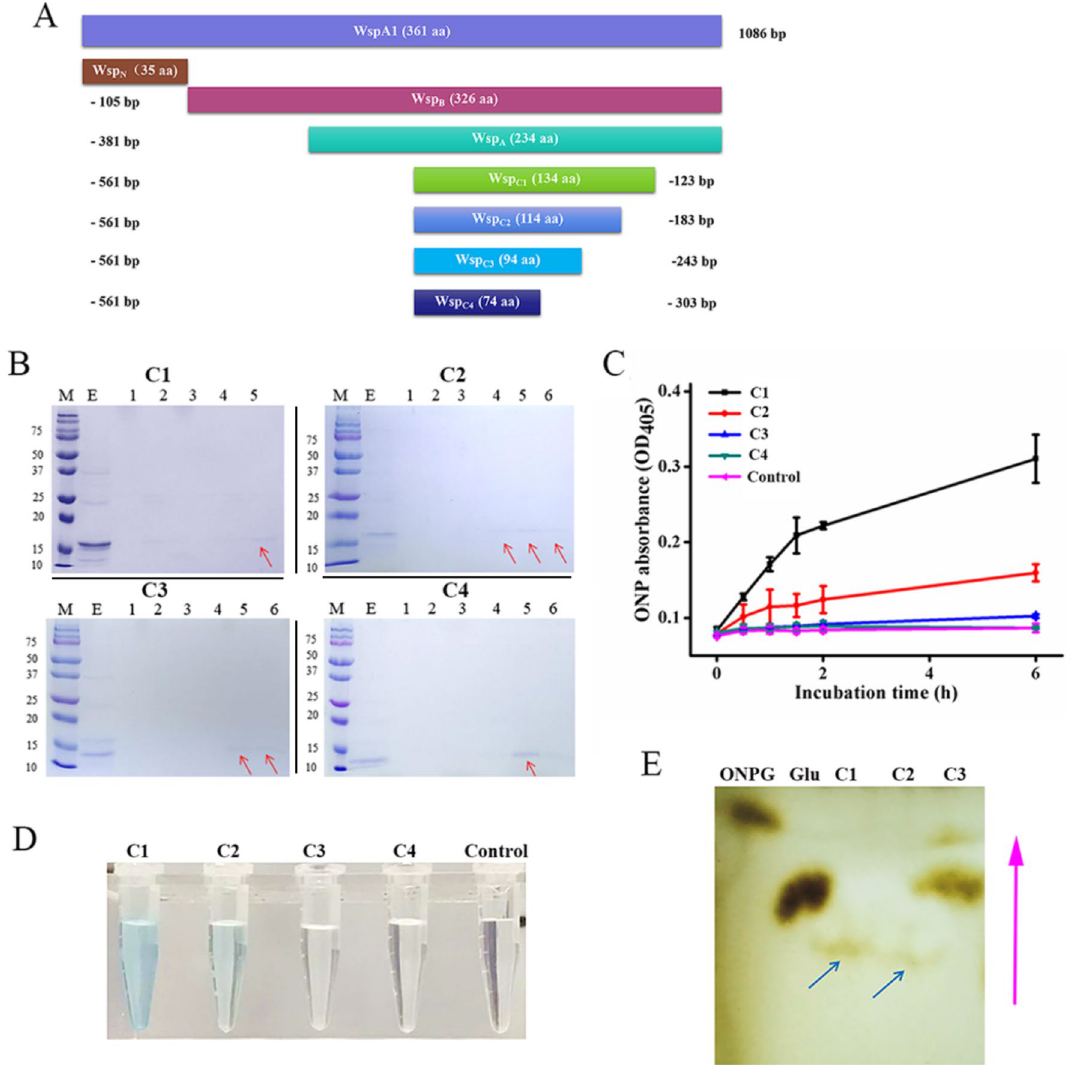
Figure 5. Biochemical analysis of the truncated proteins of WspA1. ( A ) An illustration of the truncated protein variants. ( B ) Protein profiles of the in vitro expressed and purified target proteins in SDS-PAGE gels. M marker protein, E eluted fraction. No. 1–6, the purified fractions by FPLC. The red arrows indicate the target proteins. C1, C2, C3 and C4 represent Wsp C1 , Wsp C2 , Wsp C3 , and Wsp C4 , respectively. ( C ) Comparative analysis of hydrolytic activities in 0.1 M PBS buffer (pH 7.5) with ONPG as the substrate. Data shown are means ± SD ( n = 3). Protein concentrations, 10 μg/ml. ONPG, 3 mM. Control, no addition of any protein in the reaction buffer. ( D ) In vitro activity analysis of the four proteins in X-Gal buffer (pH 7.5). Similar conditions were used as in ( C ). Reactions were performed for 6 h. ( E ) TLC analysis of the transgalactosylation activity of the truncated proteins. Glucose was used as the acceptor. Blue arrows indicate the generated products. The pink arrow indicates the solvent diffusion